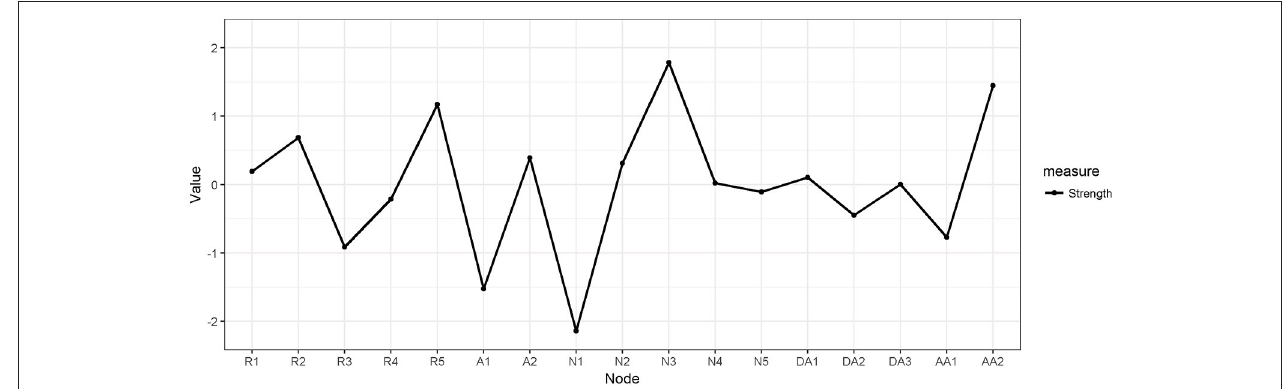
FIGURE 3 | Estimates of node strength for the symptoms of posttraumatic stress in women with sum of PCL ≥ 30.